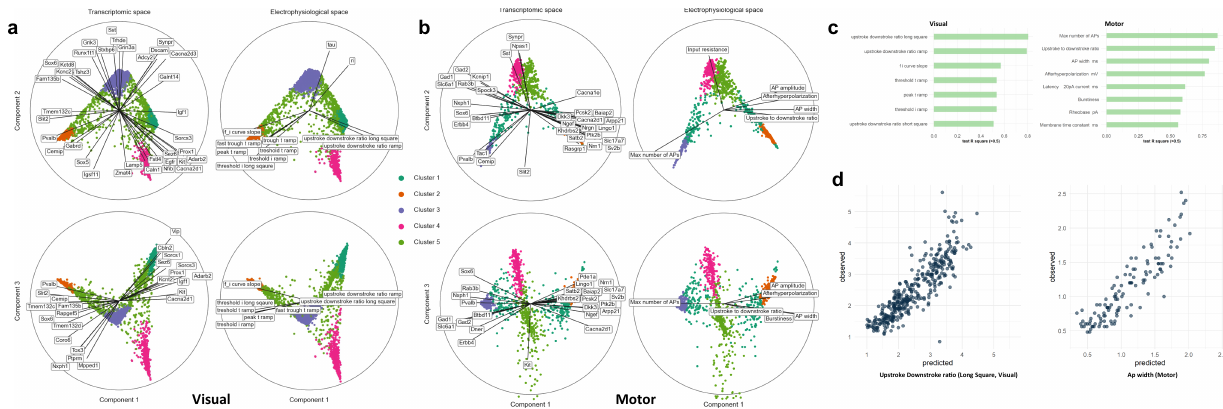
Fig. 5 Association and prediction of electrophysiological features from gene expression. a Bibiplots for the mouse visual cortex using the NMA ’ s latent spaces ( fi rst three components used). Cells are dots ( n = 3654). Transcriptomic and electrophysiological latent spaces are shown as columns. Each biplot shows the subspace of two components. Cells are colored by their cross-modal clusters. The line length of a gene or electrophysiological feature (i.e., radius) corresponds to its correlation with the latent space with max value = 1. The genes and electrophysiological features with correlations >0.6 are shown here. The label positions are slightly adjusted to avoid overlapping. b Similar to ( a ) but for the mouse motor cortex ( n = 1208). c The representative electrophysiological features in the cross-modal clusters with testing R 2 > 0.5 (90% training set, 10% testing set, see Methods). d The predicted values by gene expression ( x -axis) vs. the observed values ( y -axis) of the upstroke downstroke ratio ( R 2 ¼ 0 : 805) in the visual cortex and the action potential width ( R 2 ¼ 0 : 800) in the mouse motor